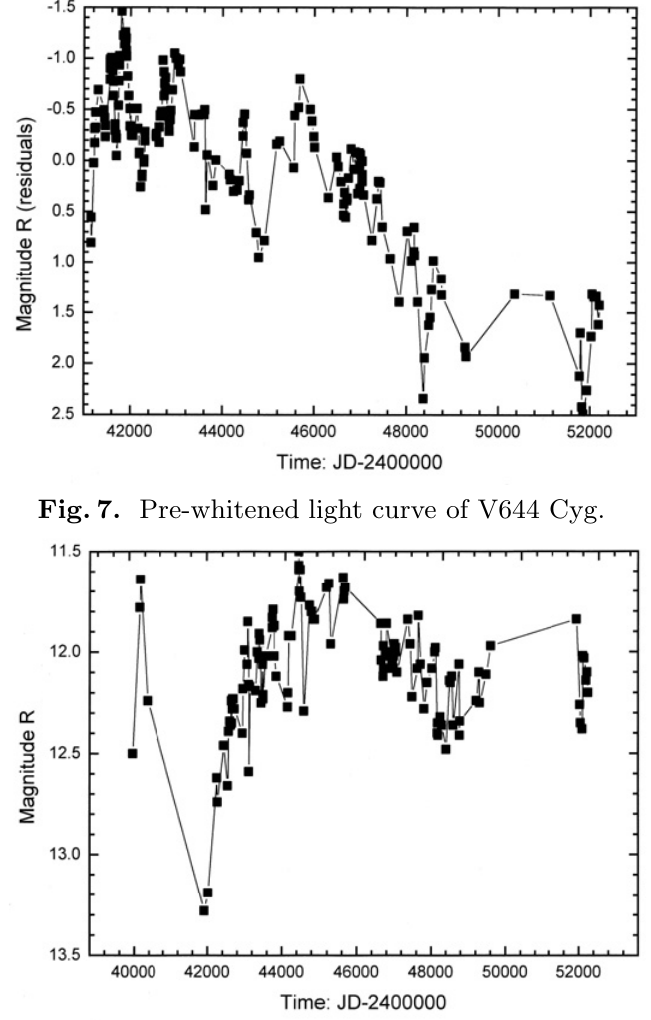
Fig. 8. Observed light curve of V2074